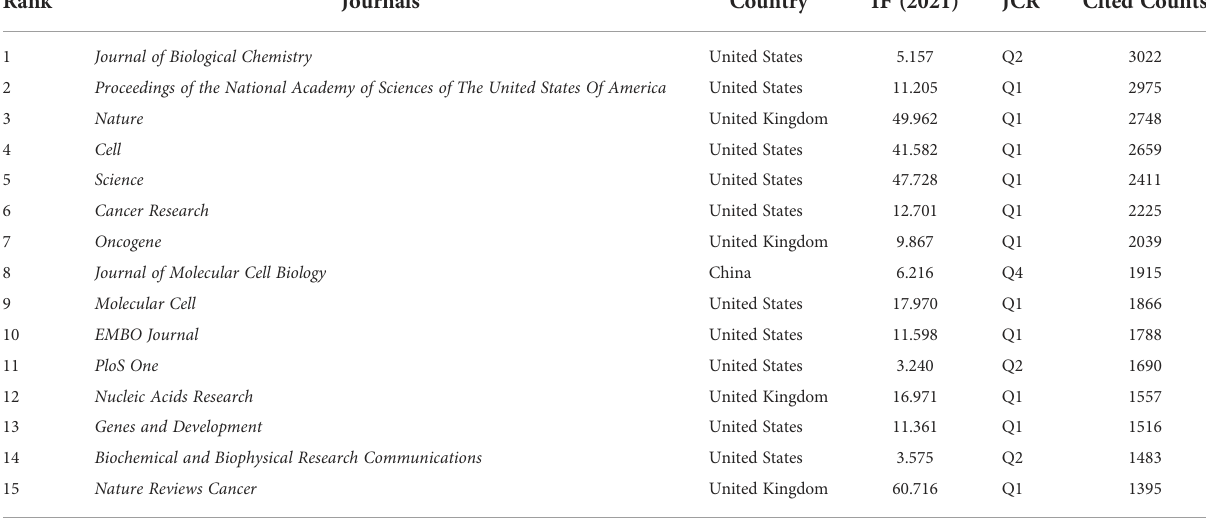
TABLE 2 The top 20 Journals involved in PTMs of cancer fi eld.